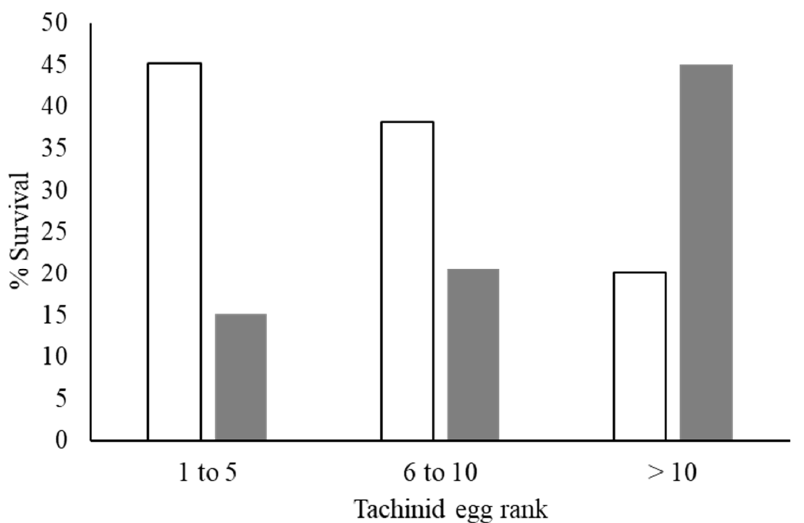
Figure 6. Relationship between the mean number of tachinid flies in response to the number of eggs per host.